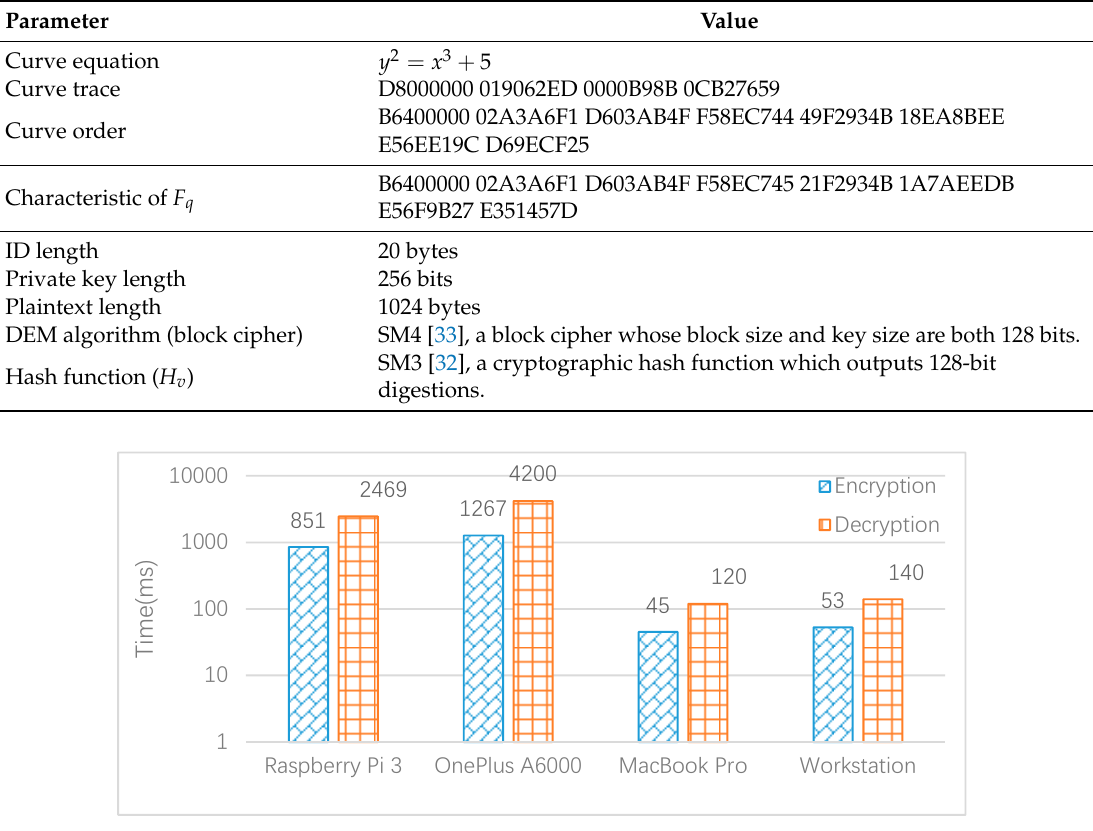
Table 2. Detailed parameters in the experiment.